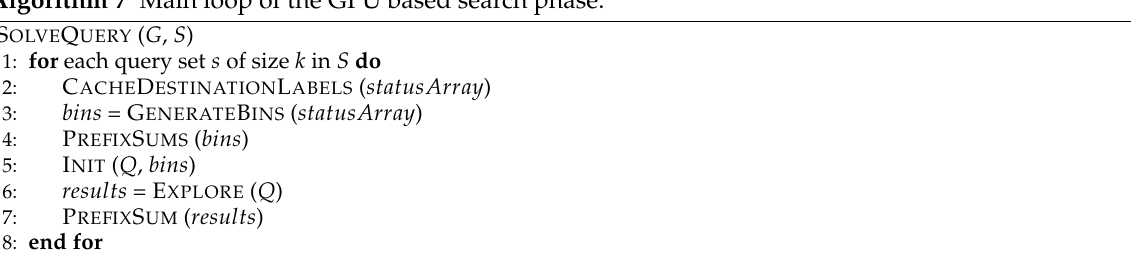
Algorithm 7 Main loop of the GPU based search